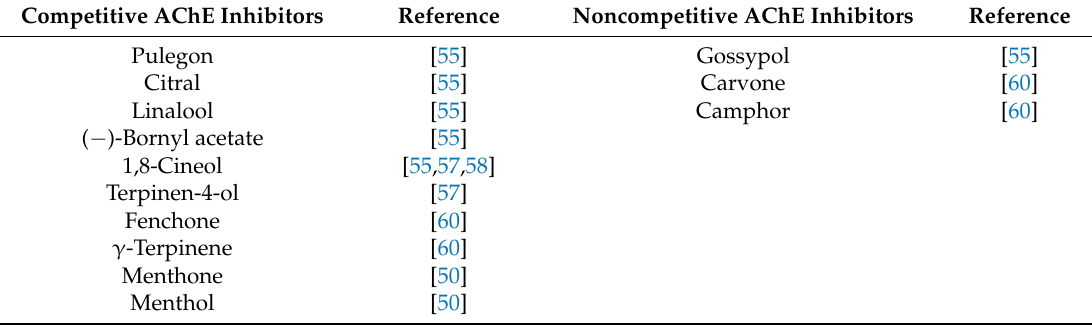
Table 2. The EO components acting as the competitive and the noncompetitive inhibitors of